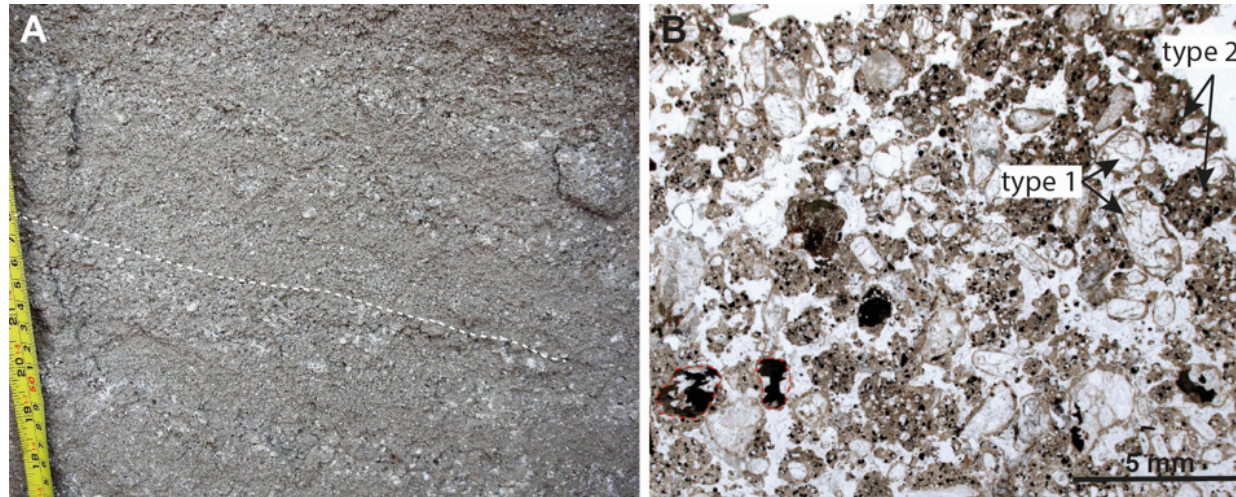
Figure 2: [A] Outcrop photo of the sampled pyroclastic deposits. Stratification is defined by variations in the abundance and size of lithic clasts. Dotted white line indicates bedding orientation. [B] Plane polarised light photomicrograph of the sampled deposits, showing Type 1 pyroclasts (each with a lithic or olivine crystal core) and Type 2 pyroclasts (no visible cores). Type 1 pyroclasts with lithic cores are outlined in red.